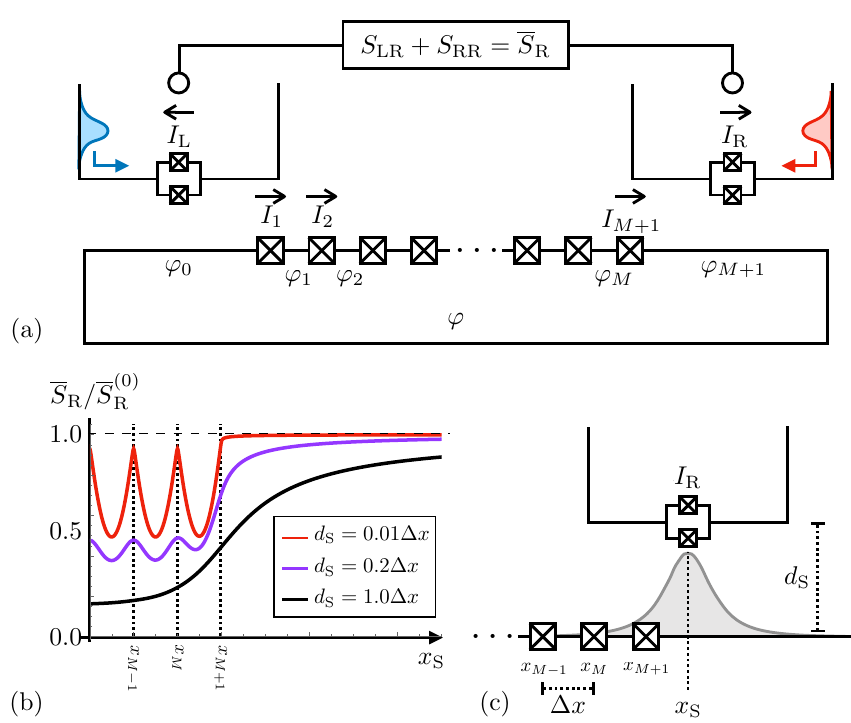
Figure 1: Illustration of the main points. (a) Two SQUID detectors measure the currents to the left ( I ) and the right ( I ) in a JJ array with a total phase bias ϕ , L R through incoming wave packets (red and blue). The signal of interest is the sum of (cid:80) γ = R). (b) The signal the current auto and cross-correlations, S γ = α S αγ (here, S depends on the detector properties (c): the lateral position x and distance to the R S circuit d , determining the detector fuzziness (represented as the grey bell curve). S ( 0 ) It reaches an extremal value S when the detector measures the current at a sharp R ( 0 ) < 1, the interface. Here, charge is measured in integer units of 2 e . For any S γ / S γ detector is fuzzy and fails to resolve integer